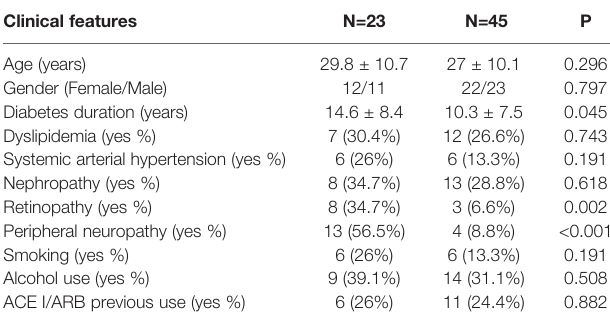
TABLE 1 | Baseline characteristics of recruited and enrolled individuals with CAN (N=23) and without CAN (N=45). Clinical features